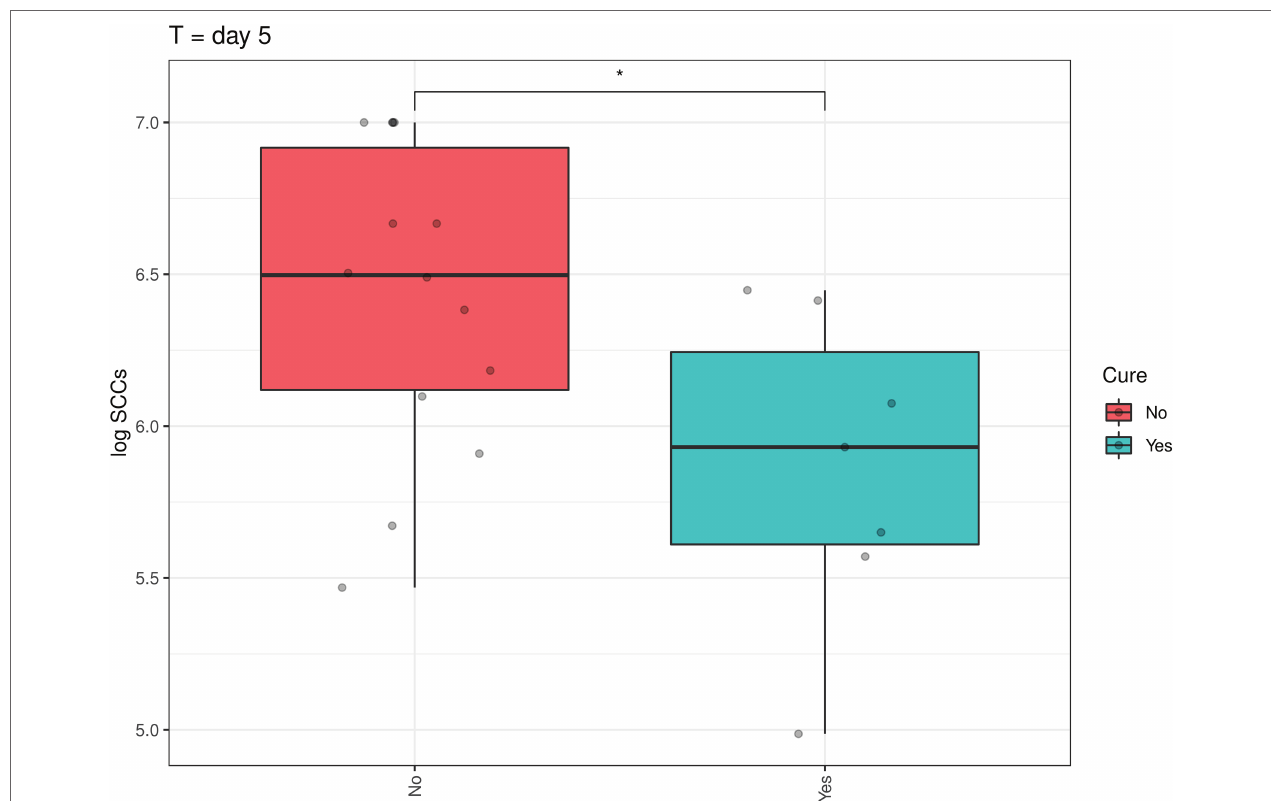
FIGURE 5 | A Wilcoxon comparison in SCC values between cured cows versus non-cured cows was conducted. The Wilcoxon test showed that there was a statistically significant difference in SCC values ( p < 0.05) between cured cows versus non-cured cows at Day 5 post-infusion, indicating that it may take up to 5 days post-infusion to see clinical differences in the cows in terms of defining a clinical